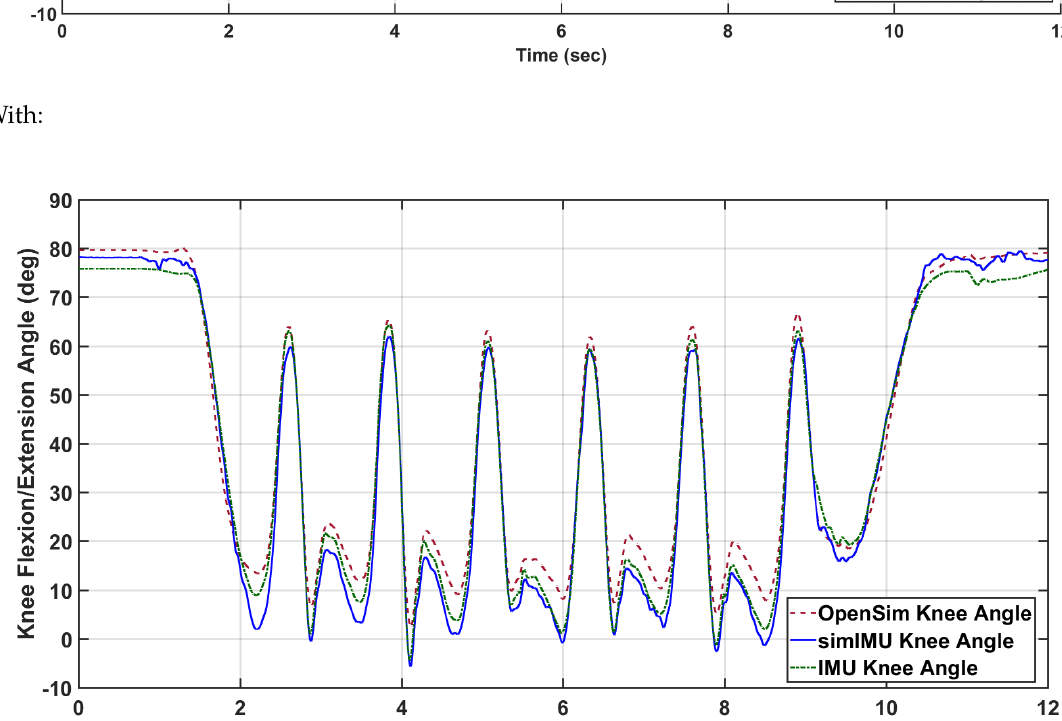
Figure 4 has been updated to represent the new